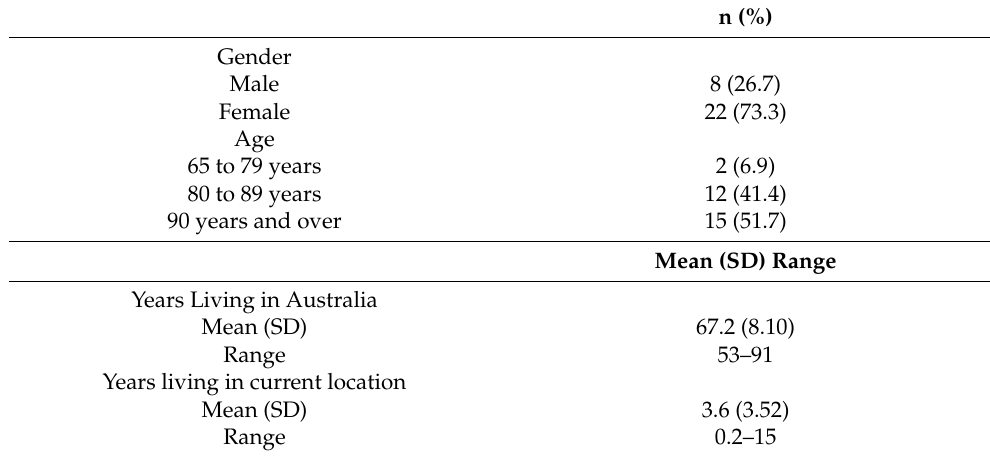
Table 3. Socio-demographic data: interview